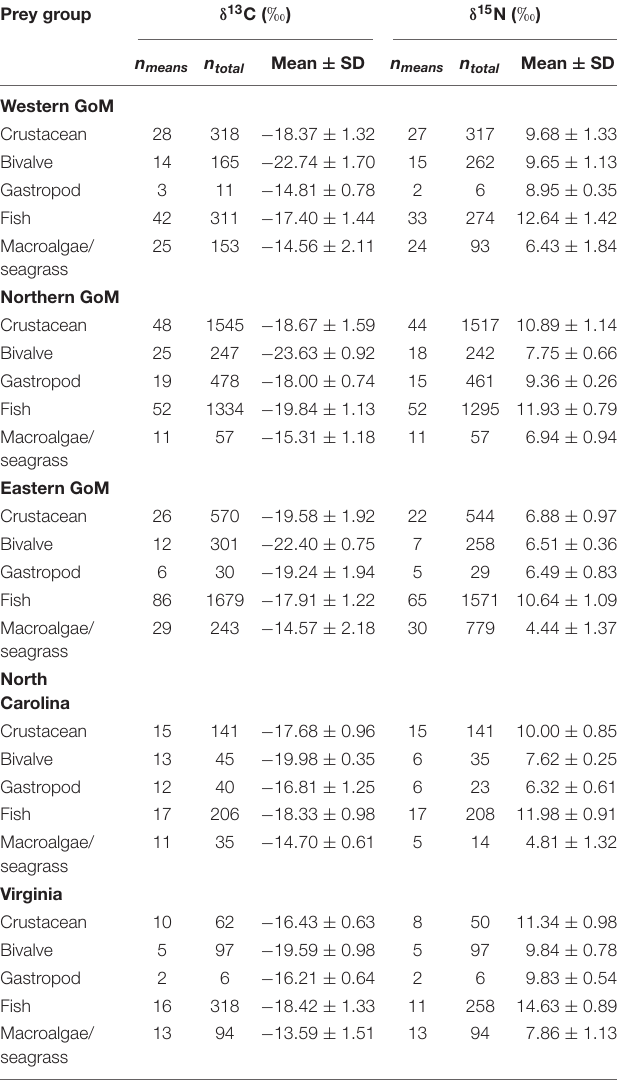
TABLE 2 | Mean ± SD stable carbon ( δ 13 C) and nitrogen ( δ 15 N) isotope ratios collated from the primary literature for Kemp’s ridley sea turtle prey groups by geographic region.